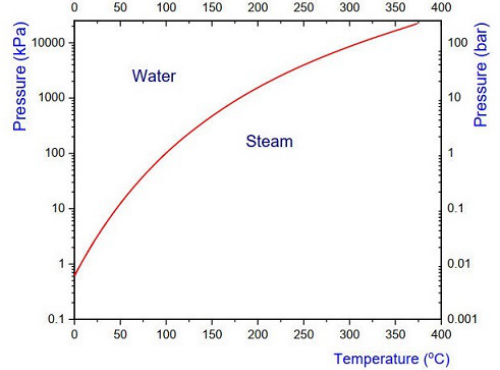
Figure 8. Plot of the water saturation pressure as a function of temperature (taken from